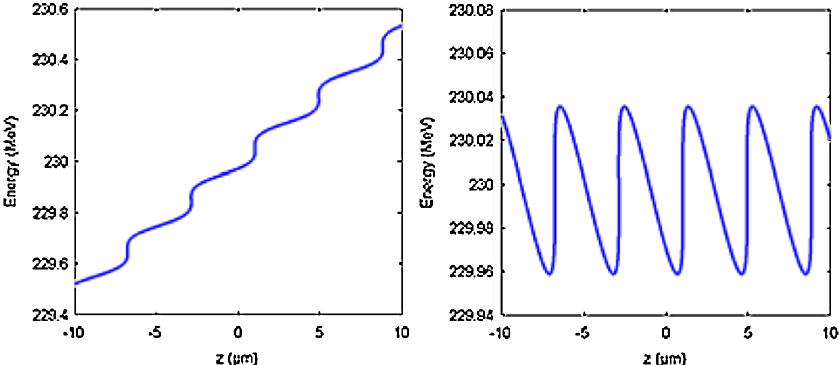
FIG. 4. (Color) 1D linear tracking of the longitudinal phase space of a bunch portion before (left) and after (right) the linear energy chirp removal.